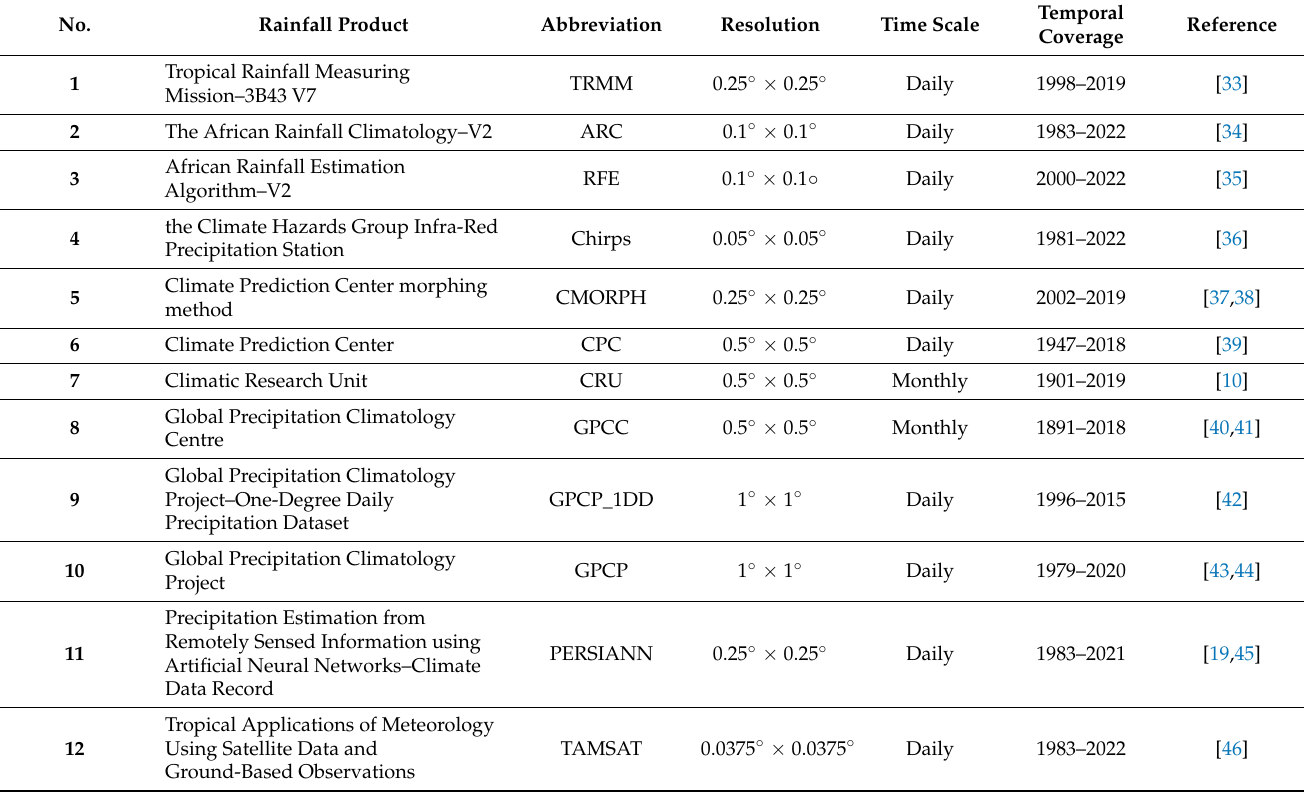
Table 1. Examined rainfall